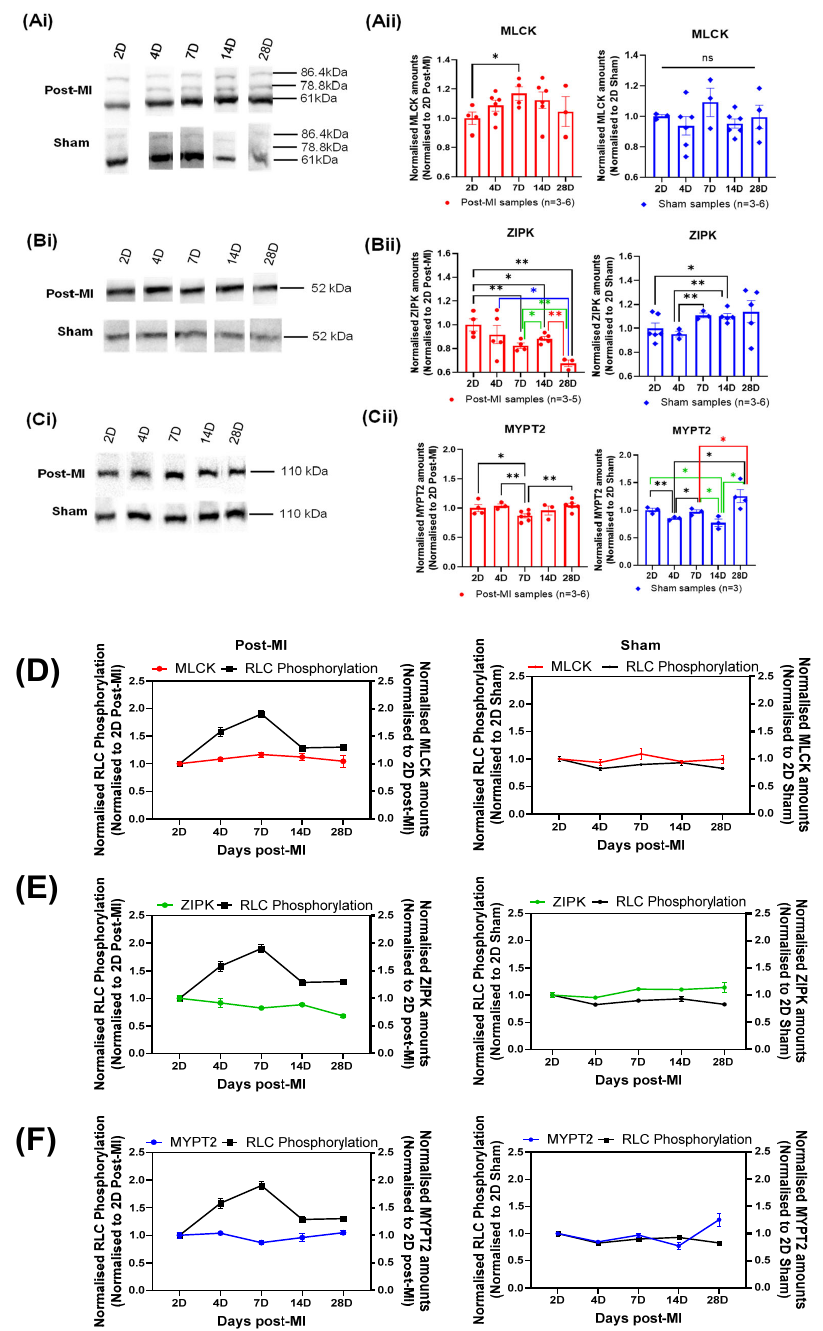
Figure 6. Longitudinal changes in enzymes in mice. ( Ai , Bi , Ci ) The blot images of MLCK, ZIPK and MYPT2, respectively. ( Aii , Bii , Cii ) Bar graph of normalised MLCK, ZIPK and MYPT2 amounts of post-MI and sham populations, respectively. All sample populations are normally distributed and validated by Shapiro–Wilk test. Differences in the standard deviations between two timepoints were tested by F-test. Unpaired one-tailed t -test with Welch’s correction (*) was performed on those with significant differences in the variances, while unpaired one-tailed t -test (*) was performed for all other samples. Note: n = 3–6, derived from at least two mice for post-MI and three mice for sham (except 7D sham, where one mouse was used). Note: ‘ n ’ refers to the number of technical replicates; * p < 0.05, ** p < 0.01. ( D – F ) Line graph plotted with normalised enzyme values and RLC phosphorylation to depict longitudinal changes in post-MI and sham